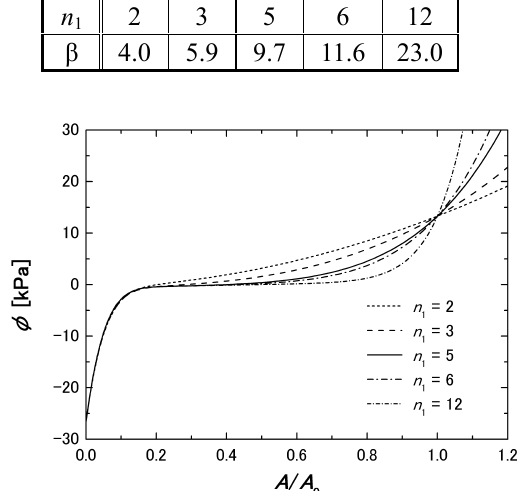
Table 1 Correspondence table between parameter n 1 of tube law and stiffness parameter β .